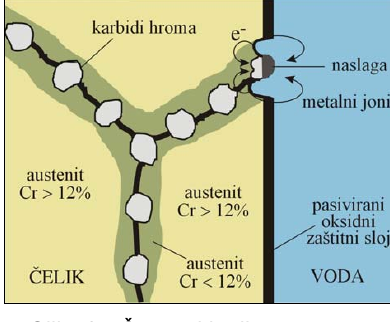
Рис . 8 – Схематическое изображение процесса сенсибилизации Figure 8 – Schematic representation of the process of